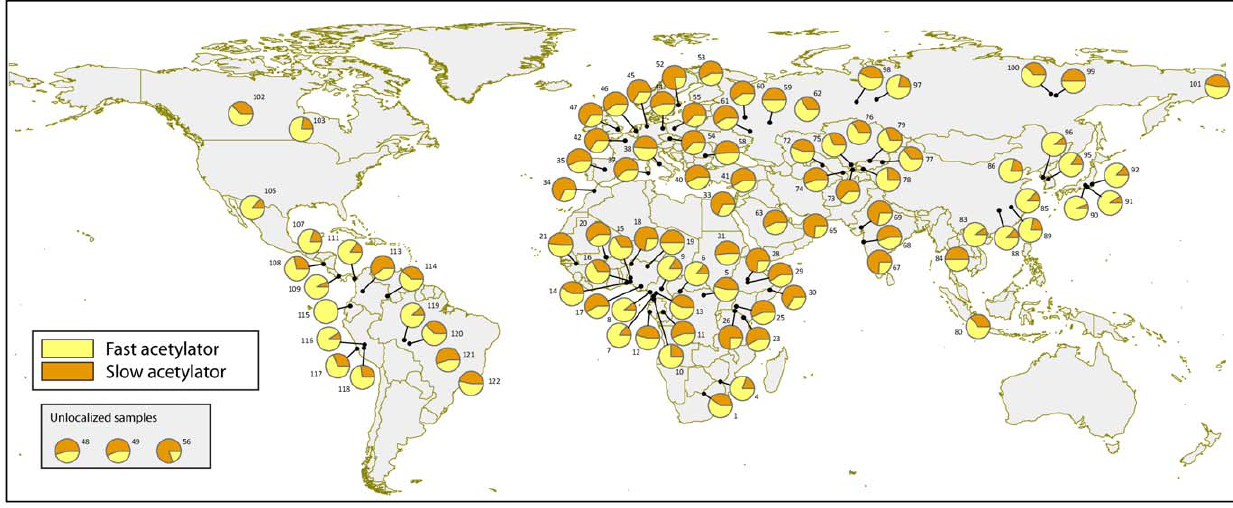
Figure 3. Distribution of inferred acetylation phenotypes based on genotype data. Each pie chart reports the percentage of fast (yellow) and slow (orange) acetylators in each of the 99 population samples included in the worldwide diversity survey, except for two samples where phenotype data were not available (samples 93 and 94). Intermediate acetylators were included into the fast acetylation phenotype. Three samples could not be localized on the map because of unspecified sampling location (sample 56) or because of divergence between sampling location and region of origin (samples 48 and 49); the pie charts of these samples are displayed in a box beneath the caption.